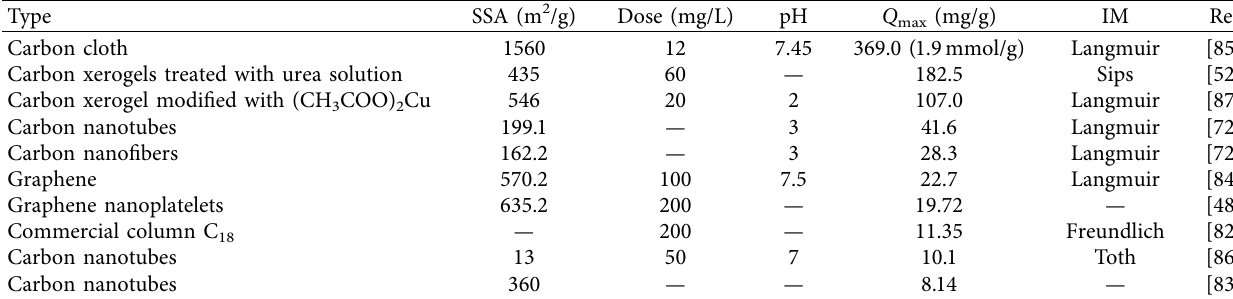
Table 5: Summary of characteristics of carbon-based adsorbents and conditions of the adsorption process.